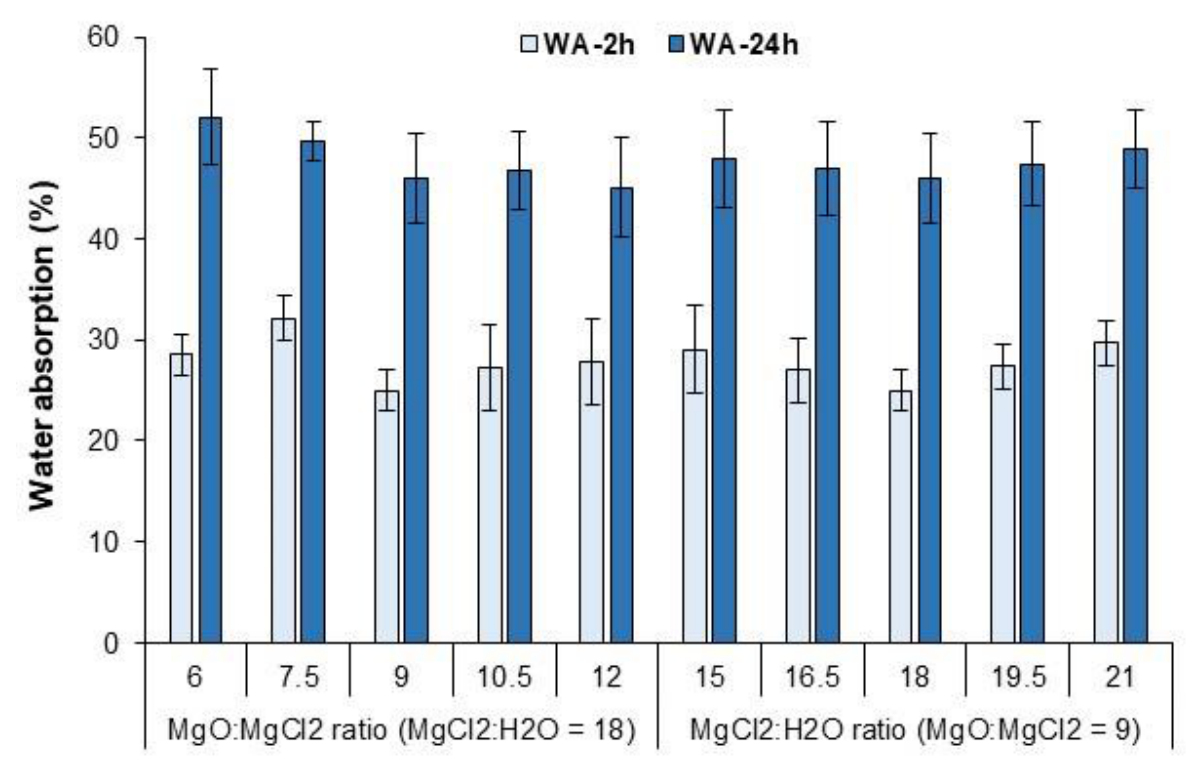
Figure 10. Water absorption of plywood samples during bending using MOC binders with different molar ratios of the components.